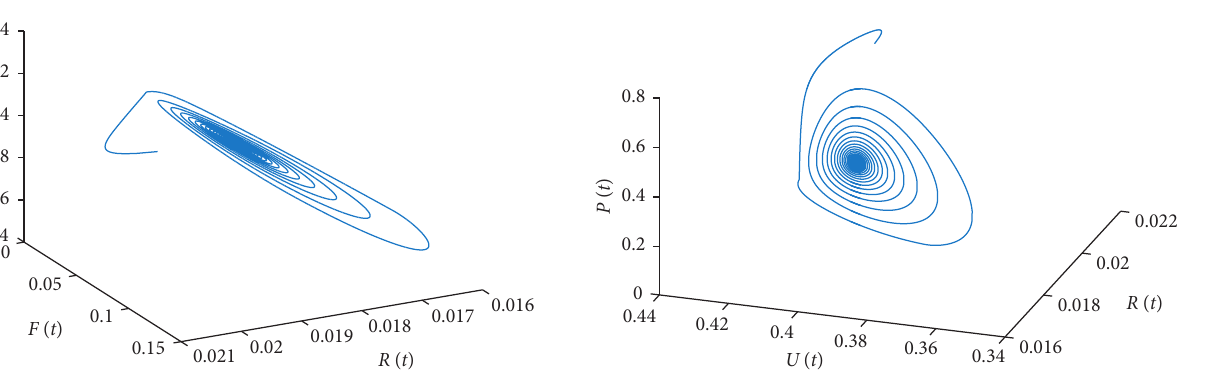
Figure 5: Portrait diagram of land model (30) with ϕ � 0 . 90, � 728 . 403. τ � 700 < τ 0